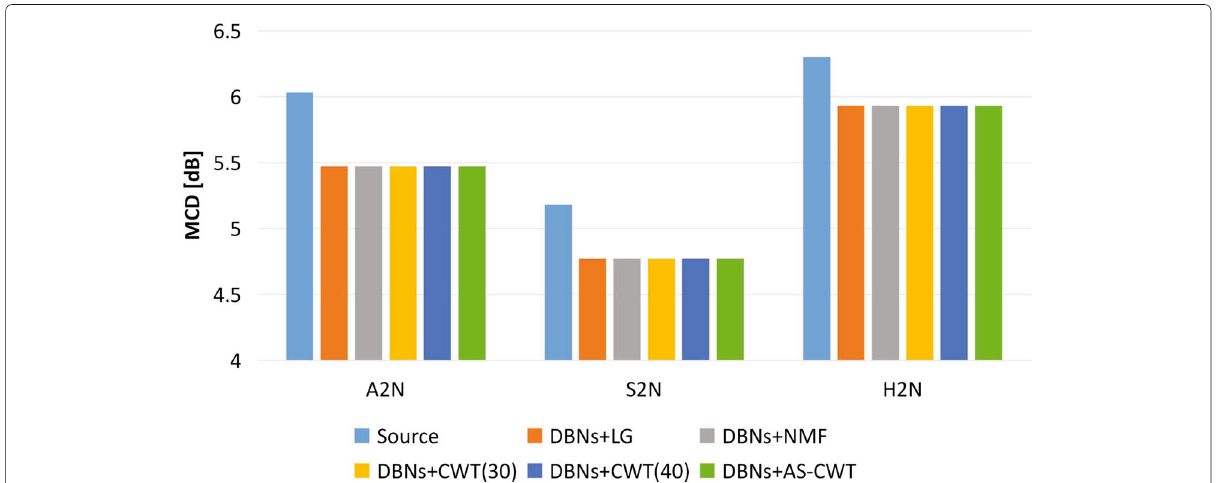
Fig. 9 Mel-cepstral distortion evaluation of spectral features conversion from emotional to neutral voices